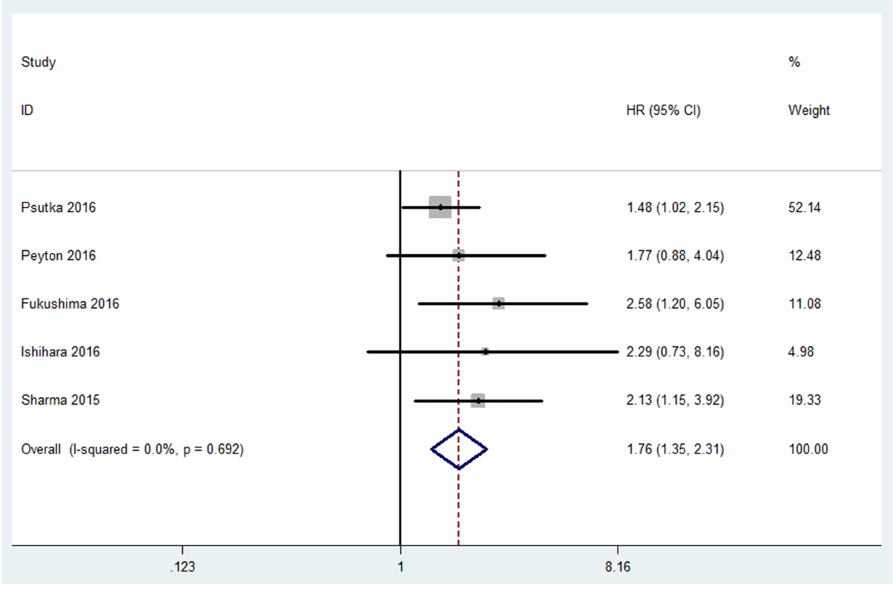
Figure 2 - Meta-analysis of the association between sarcopenia and OS in patients with